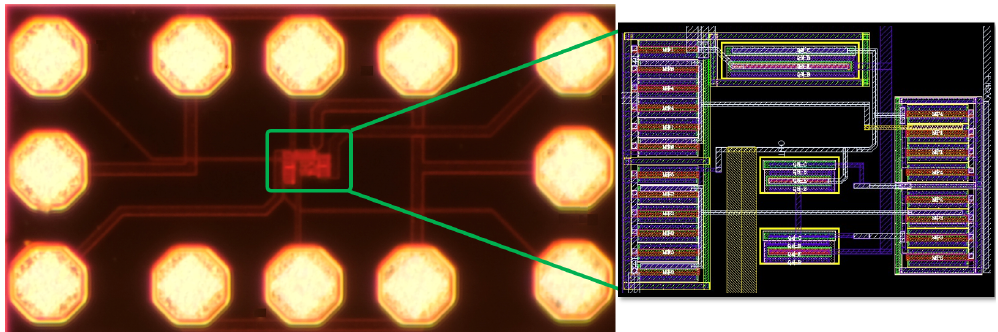
Figure 9. Die micro-photograph of the